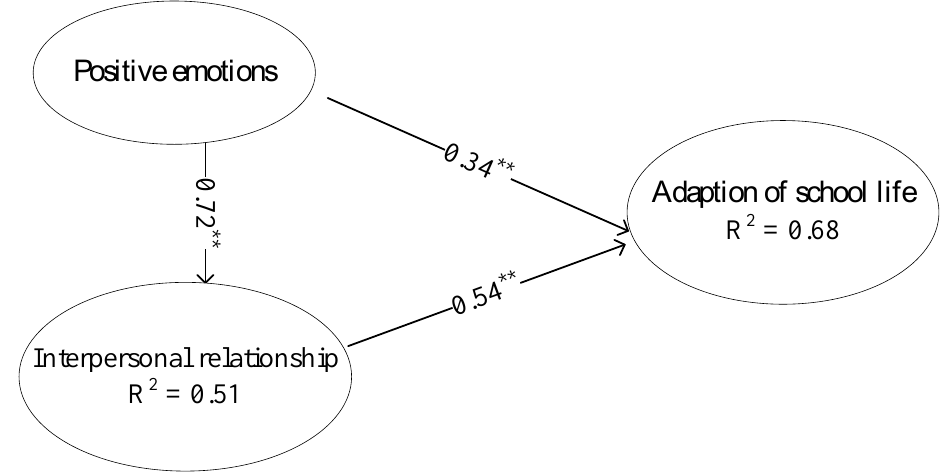
Figure 2. Standardized parameter estimation of overall model. Note: ** p < 0.01.